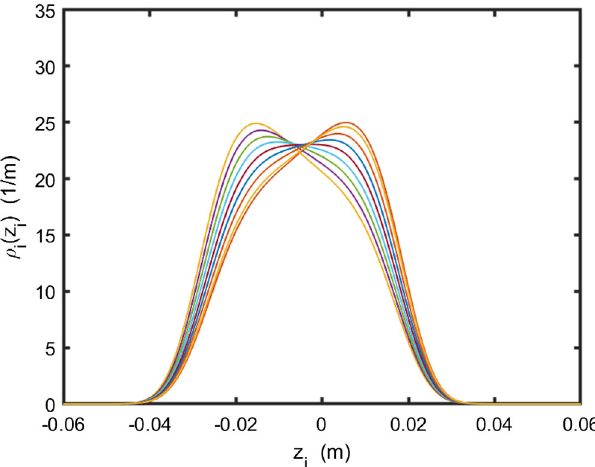
FIG. 7. Centroids h z i in a train of 26, surrounded by gaps of 4 buckets, with cavity beam loading (blue) and without (red). ¼ 496 mA. ¼ 496 mA. I av av